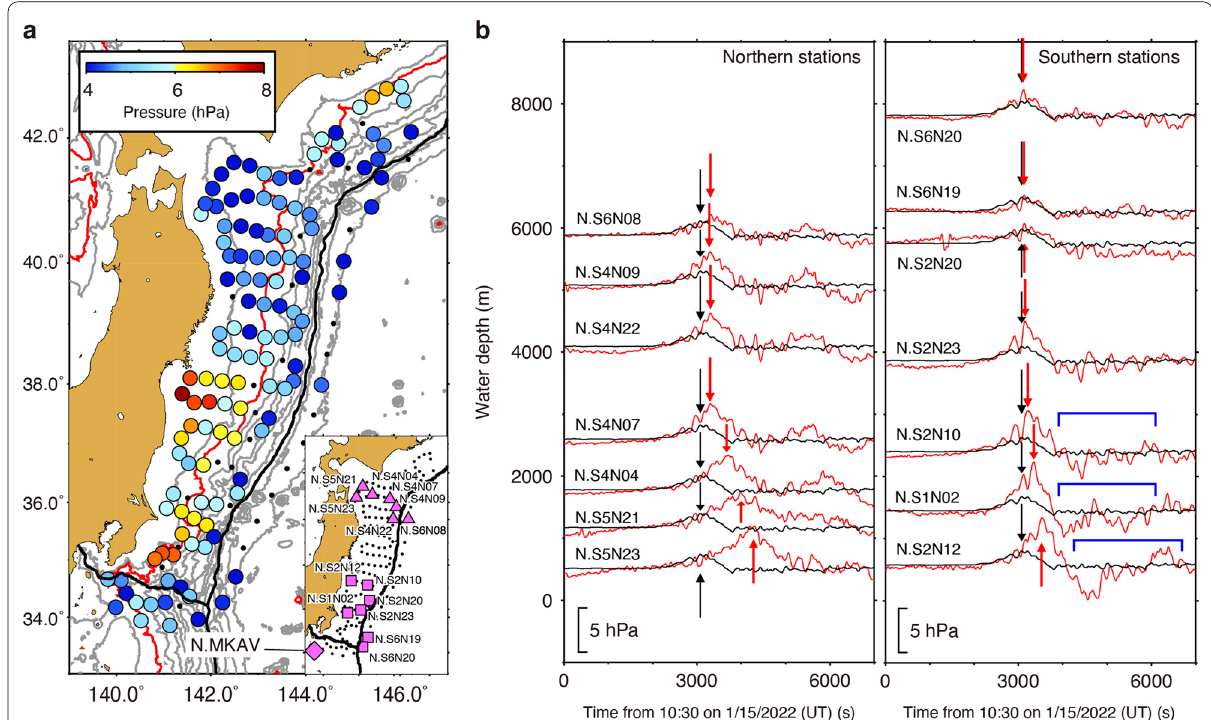
Fig. 3 Amplitudes and waveforms of meteotsunamis and free waves. a Peak amplitudes of the first arrivals at each station of S-net. Inset represents the locations of stations used in b . b (left) Red lines show the time-shifted APG records observed at stations indicated by triangles in the inset in a . The black line represents the barometer record observed at N.MKAV in the inset in a . Black and red arrows point to the maximum amplitudes of barometer and APG records, respectively. (right) Same as the left panel, but for stations indicated by squares in the inset in a . Blue square brackets indicate large amplitudes after the first